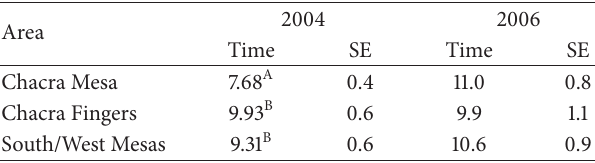
Table 6: Mean water infiltration time (sec) in 3 graze survey areas, Chaco Culture National Historic Park, 2004 and 2006. 2004 2006 Area Time SE Time SE Chacra Mesa 7.68 A 0.4 11.0 0.8 Chacra Fingers 9.93 B 0.6 9.9 1.1 South/West Mesas 9.31 B 0.6 10.6